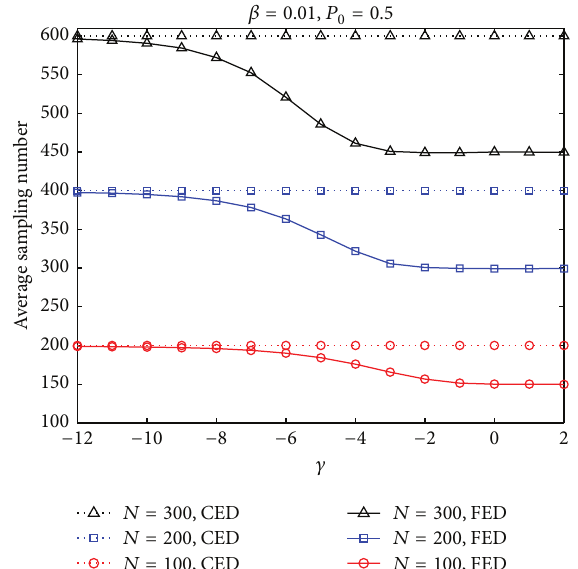
Figure 5: Comparison of average sampling number under different 𝑁 .